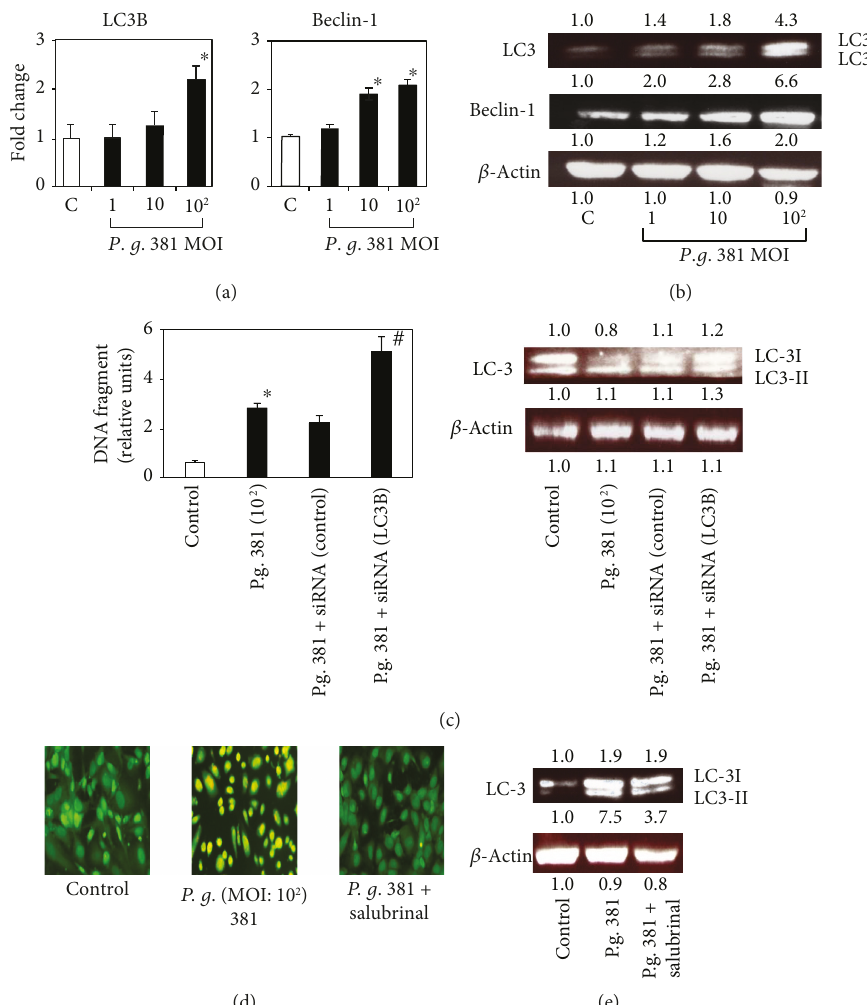
Figure 3: P. gingivalis 381 triggers ER stress-induced autophagy in HUVEC. (a) HUVEC were treated with P. gingivalis 381 at an MOI